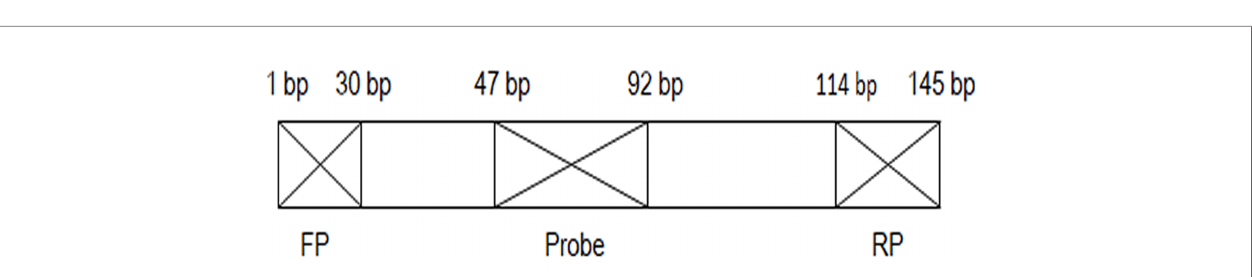
FIGURE 1 | Position relationship diagram of primers and probe on the DNA sequence. FP, forward primer; RP, reverse primer; bp, base